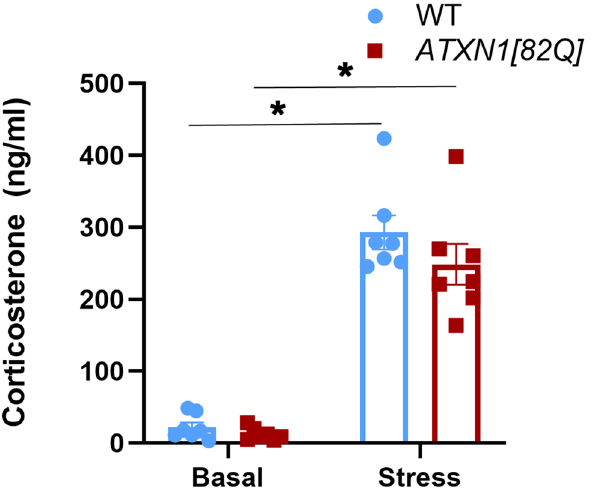
Figure 4. Basal and stress-induced blood corticosterone levels in ATXN1[82Q] and wild-type control mice. Corticosterone levels were determined in total plasma from 7 pairs of ATXN1[82Q] mice and littermate WT controls. Basal/minimally stressed plasma was obtained in the morning (9–12 am) at least three days before stress induction. Stress level blood samples were collected after 15 min of restraint stress. * indicates P < 0.05 using the unpaired, two-tailed t test, data are presented as mean ±